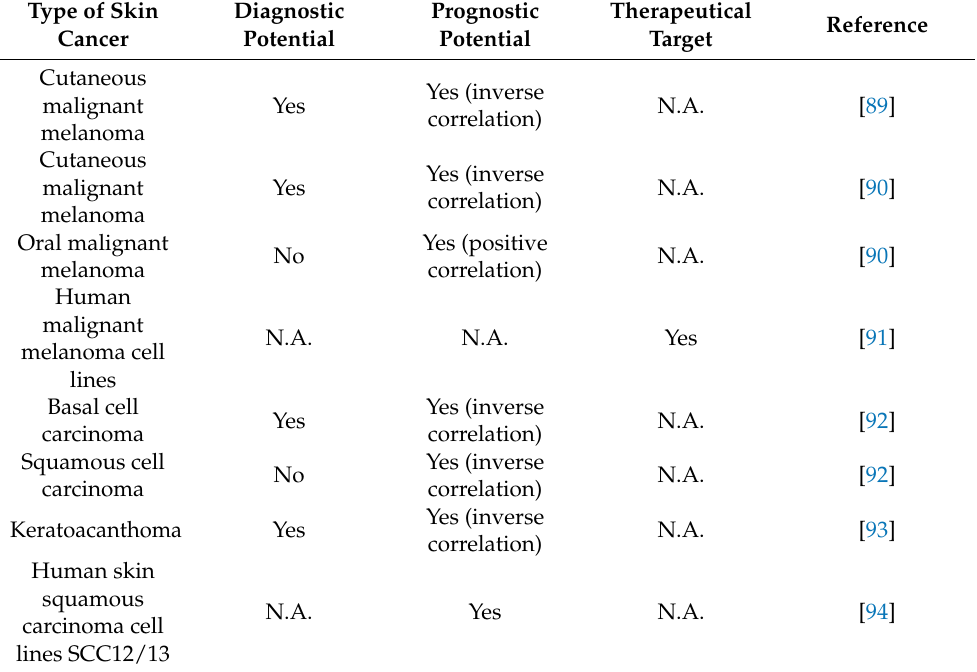
Table 1. Summary of studies exploring the role of NNMT in